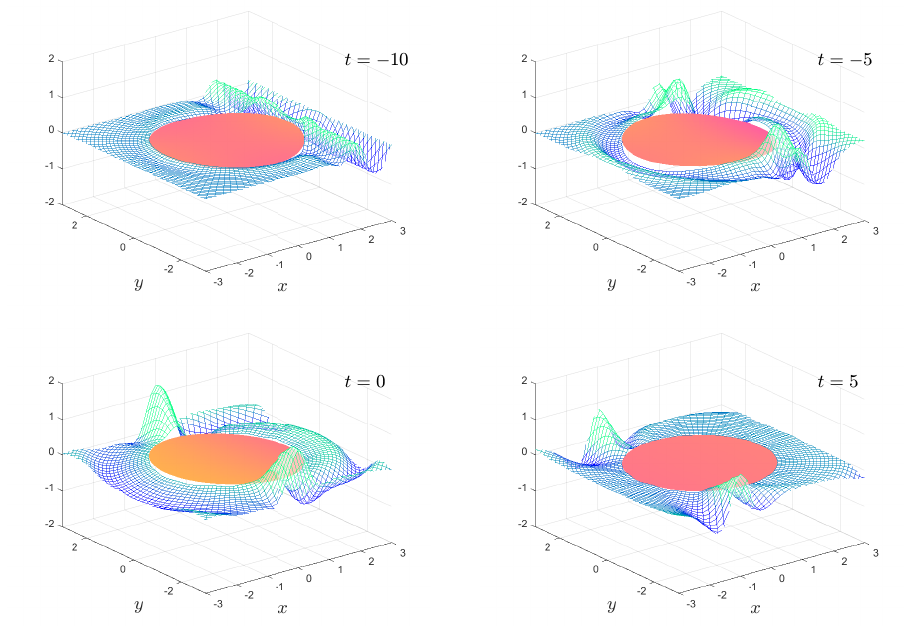
Figure 2. The time-dependent motion β = 1 × 10 − 1 , γ = 0, h = 1 and a = 2 for the times shown. The full animation can be found in movie